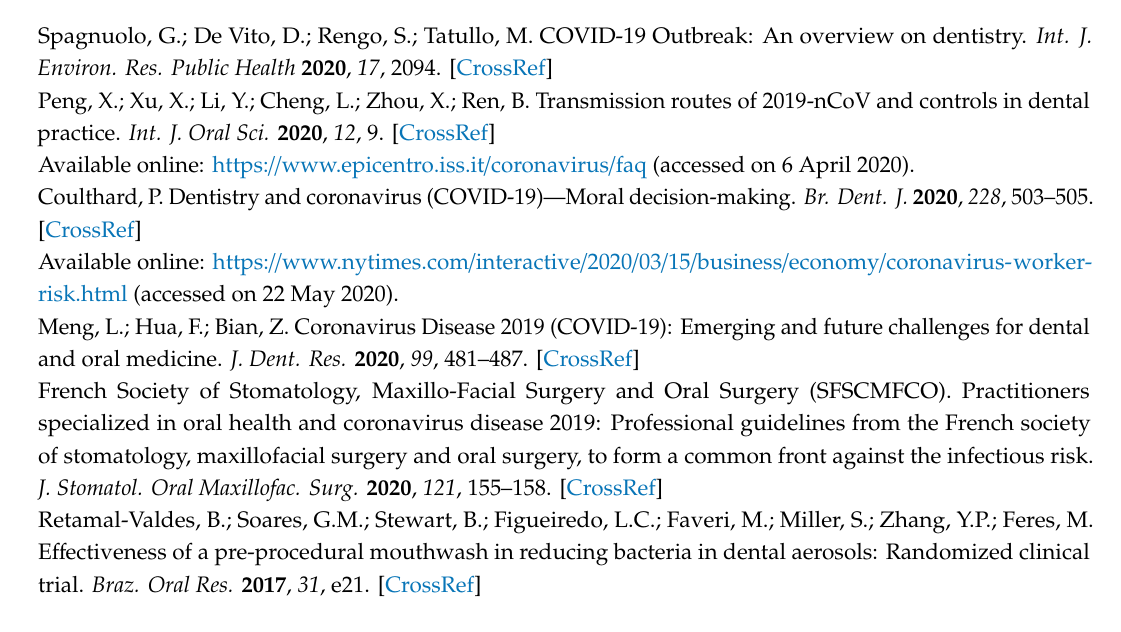
Table S1: Non surgical periodontal therapy and laser, Table S2: Non surgical periodontal therapy and ozone, Table S3: Non surgical periodontal therapy and air-polishing, Table S4: Non surgical periodontal therapy and probiotics, Table S5: Non surgical periodontal therapy and